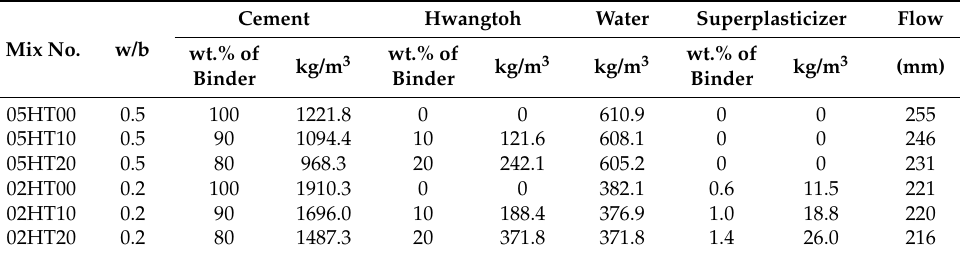
Table 2. Mix design information in this